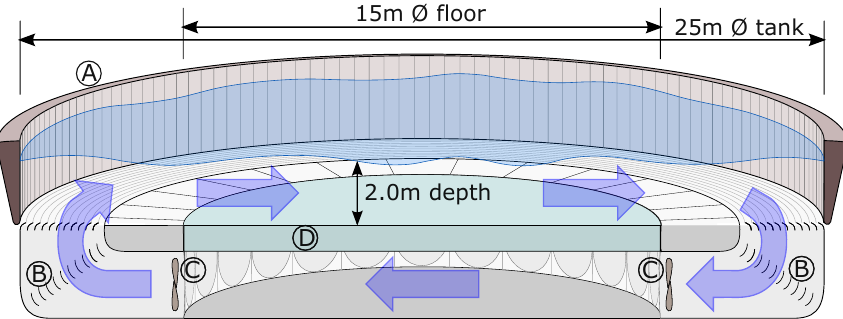
Sectional schematic of FloWave basin showing: ( A ) wavemaker paddles around circumference; ( B ) turning vanes and flow conditioning filters; ( C ) current drive impeller units; ( D ) buoyant raisable floor (15 m ) below test area (cid:31)